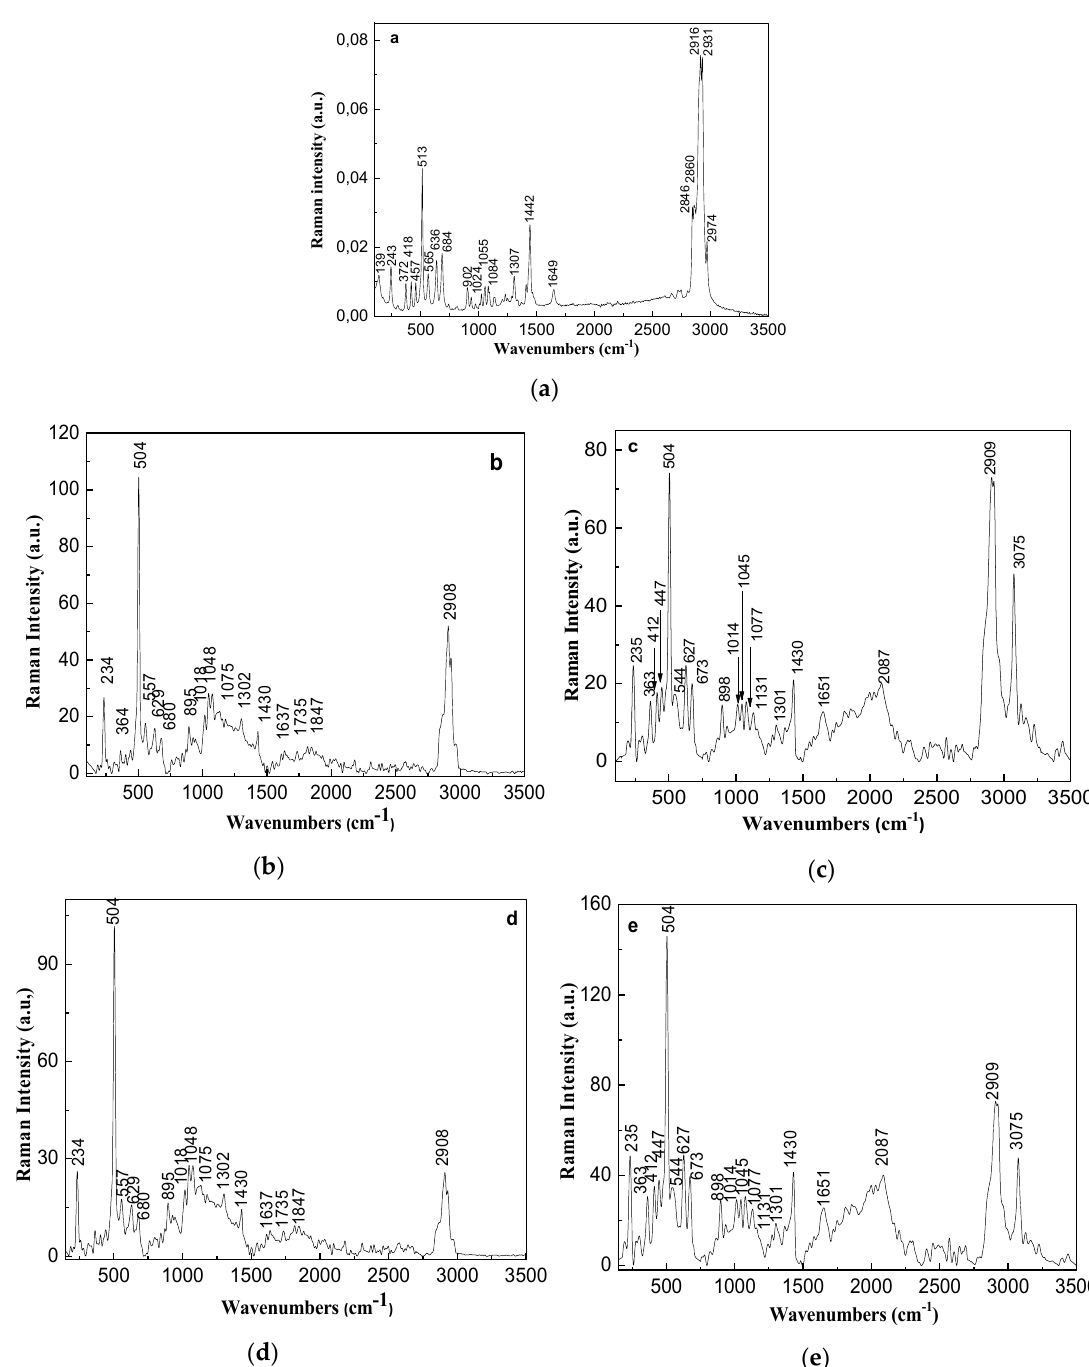
Figure 9. Raman spectra of ALA in a solid state ( a ) and as layers deposited onto metallic films prepared using colloidal solutions of Au nanoparticles with sizes of 5 nm ( b ) and 10 nm ( c ) and of Ag nanoparticles with sizes of 5 nm ( d ) and 10 nm ( e ). The ALA layers were obtained by using ALA solutions with a concentration of 10 − 2 M.